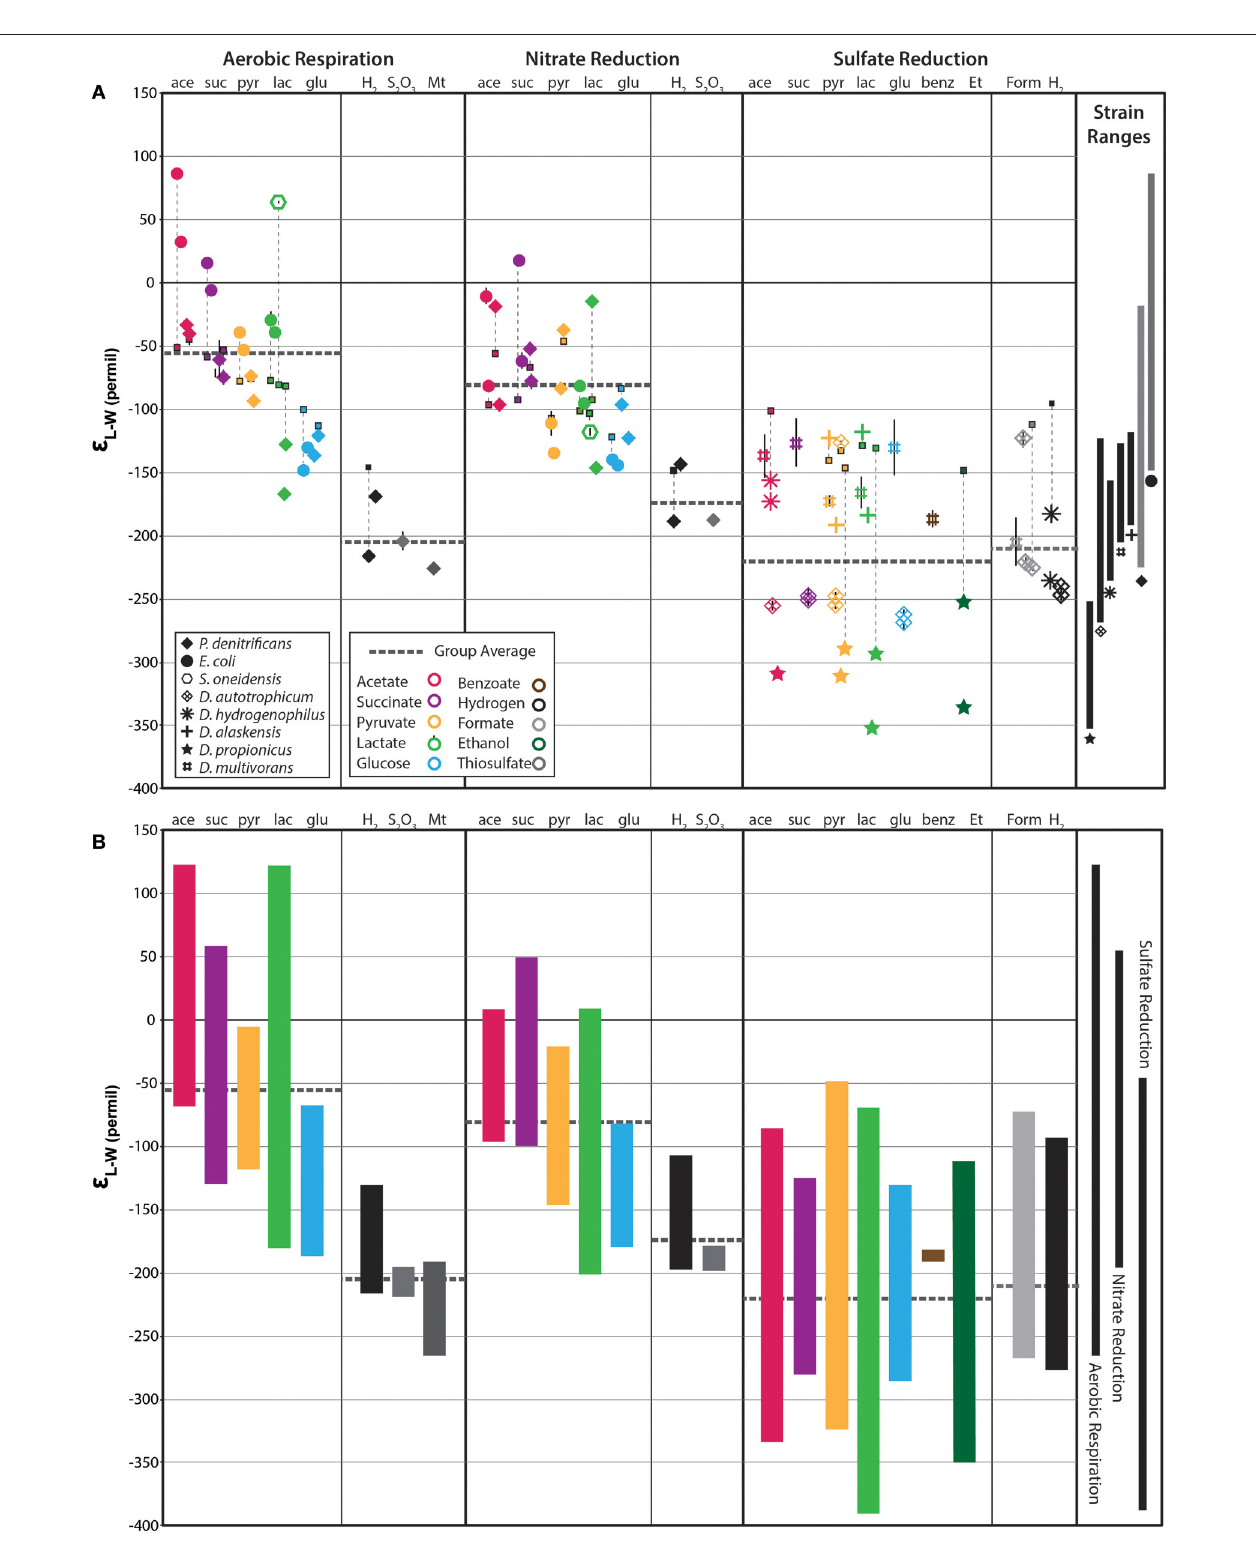
FIGURE 1 | Fractionations between fatty acids and water ( ε L-W ) for all non-labeled experiments. (A) Individual symbols represent the abundance-weighted average ε L-W for all fatty acids measured in a given culture experiment. Bulk biomass δ 2 H-values are shown as small squares with thin vertical dashed lines extending